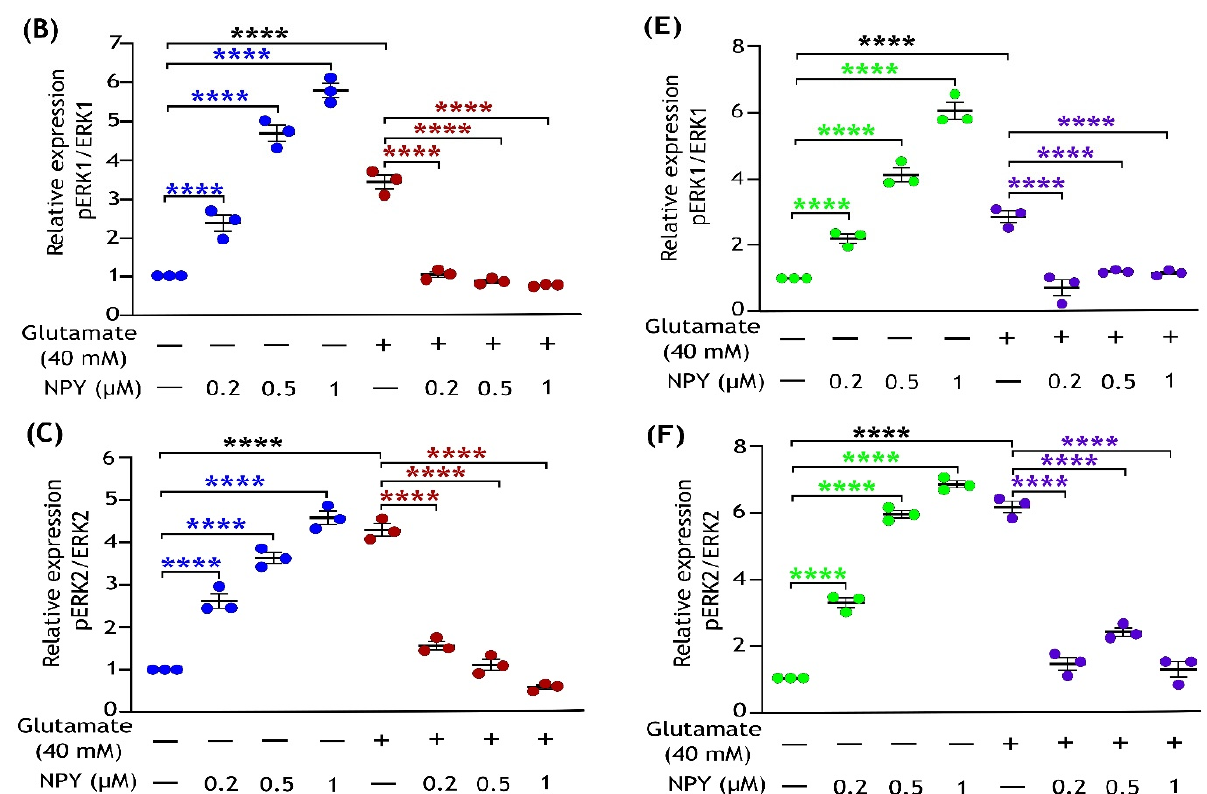
Figure 2. Dose-dependent inhibitory effects of Neuropeptide Y on glutamate-induced activation of ERK1/2 in SH-SY5Y cell cultures. Western immunoblot analysis illustrates the increased phosphor- ylation of ERK1/2 (T202/Y204) with NPY treatments in the absence of glutamate (control + NPY) at different concentrations, while NPY treatment reduced the glutamate-induced (glutamate + NPY) phosphorylation of ERK1/2 at 12 h treatment ( A ) and densitometric quantification of ERK1 ( B ) and ERK2 ( C ) blot densities indicate a significant increase in ERK1/2 phosphorylation under glutamate treatment compared to control (F(1,16) = 347.7 in Figure ( B ) and F(1,16) = 145.1 in Figure ( C ), **** p < 0.0001, n = 3) and this activation significantly decreased with increasing concentration of NPY treatment for 12 h (F(3,16) = 29.21 in Figure ( B ) and F(3,16) = 8.319 in Figure ( C ), **** p < 0.0001 represents significance between control and NPY group (blue), **** p < 0.0001 represents significance between glutamate and glutamate + NPY group (red), n = 3). Western immunoblot analysis for 24 h treatment ( D ) and their densitometric quantification of ERK1 ( E ) and ERK2 ( F ) blot densities indi- cates a significant increase in ERK1/2 phosphorylation under glutamate treatment compared to con- trol (F(1,16) = 254.6 in Figure ( E ) and F(1,16) = 182.3 in Figure ( F ), **** p < 0.0001, n = 3) and a signif- icant decrease in the glutamate induced phosphorylation of ERK1/2 with increasing concentration of NPY treatment (F(3,16) = 63.96 in Figure ( E ) and F(3,16) = 59.63 in Figure ( F ), **** p < 0.0001 rep- resents significance between control and NPY group (green), **** p < 0.0001 represents significance between glutamate and glutamate + NPY group (purple), n = 3).